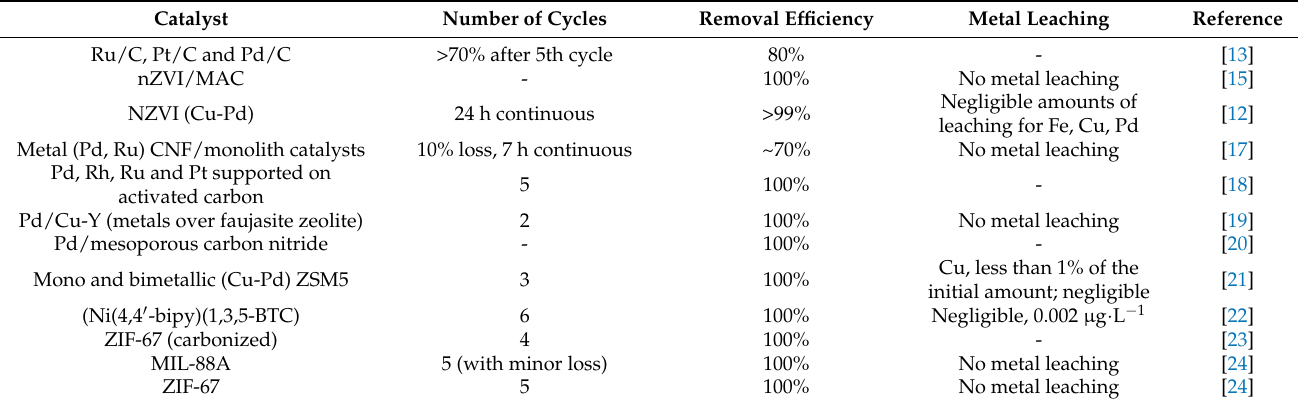
Table 2. A summary of durability test results by nanoscale heterogeneous catalysts for repeated cycles of BrO 3 −